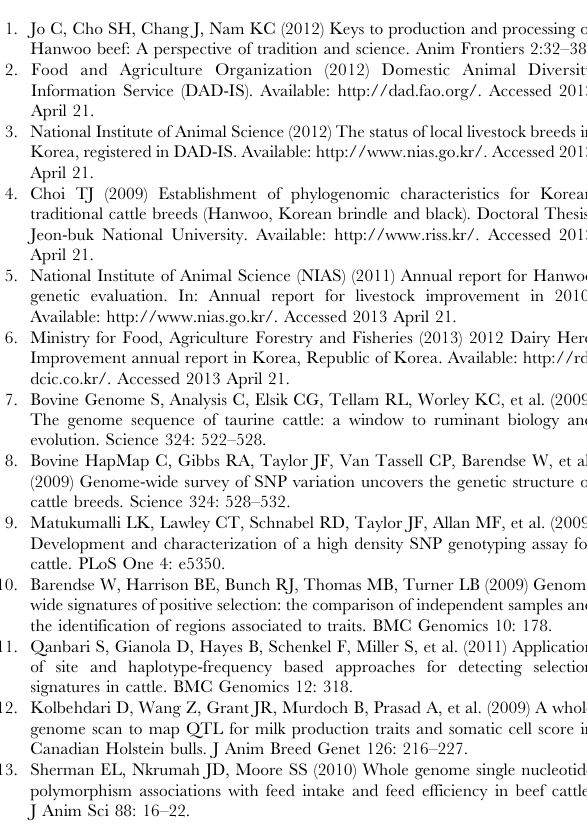
Table S1 CNVRs detected from HANvsHOL. (PDF) Table S2 CNVRs detected from JJHvsHOL. (PDF) Table S3 CNVRs detected from CHSvsHOL. (PDF) Table S4 Annotated genic-CNVR detected from HANv- sHOL. (XLSX) Table S5 Annotated genic-CNVR detected from JJHvsHOL. (XLSX) Table S6 Annotated genic-CNVR detected from CHSvsHOL. (XLSX) Table S7 Gene Ontology terms enriched among the top 100 genes containing the highest number of nsSNPs in each of breed-specific nsSNPs. HAN, JJH, CHS, and HOL indicate Hanwoo, Jeju Heugu, Chikso, and Korean Holstein respectively. (PDF) Table S8 Gene Ontology terms enriched among the genic-CNVRs from HANvsHOL. (PDF) Table S9 Gene Ontology terms enriched among the genic-CNVRs from JJHvsHOL. (PDF)